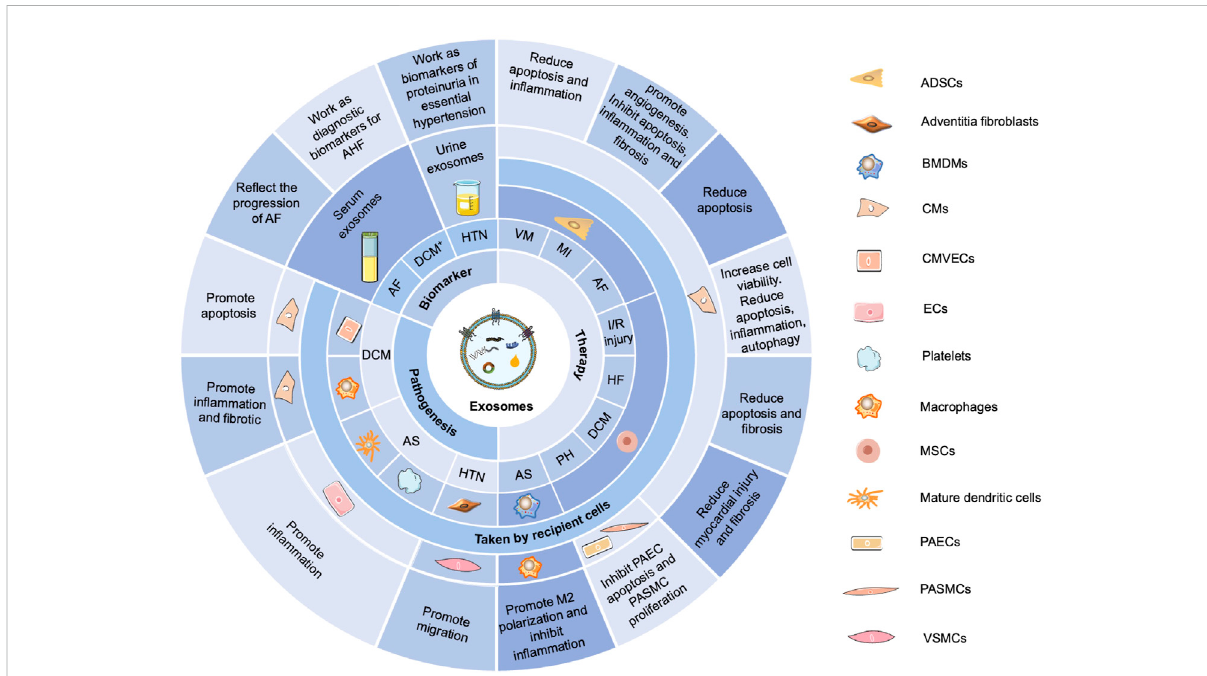
FIGURE 2 FunctionsofexosomesinCVDs.Exosomesindifferentbody fl uids,suchasserumandurine,functionasbiomarkerstore fl ecttheprogressionof many diseases, such as AF, dilated cardiomyopathy (DCM + ), and hypertension (HTN). Exosomes can promote apoptosis, migration, in fl ammation, and cardiac fi brosis in diabetic cardiomyopathy (DCM), AS, and HTN. Exosomes derived from adipose-derived stem cells (ADSCs), mesenchymal stem cells (MSCs), or bone marrow – derived macrophages (BMDMs) exert therapeutic effects in viral myocarditis (VM), MI, AF, I/R injury, HF, DCM, PH, and AS. AHF, acute heart failure; CMVECs, cardiac microvascular endothelial cells; ECs, endothelial cells; PAECs, pulmonary arterial endothelial cells; PASMCs, pulmonary arterial smooth muscle cells; VSMCs, vascular smooth muscle